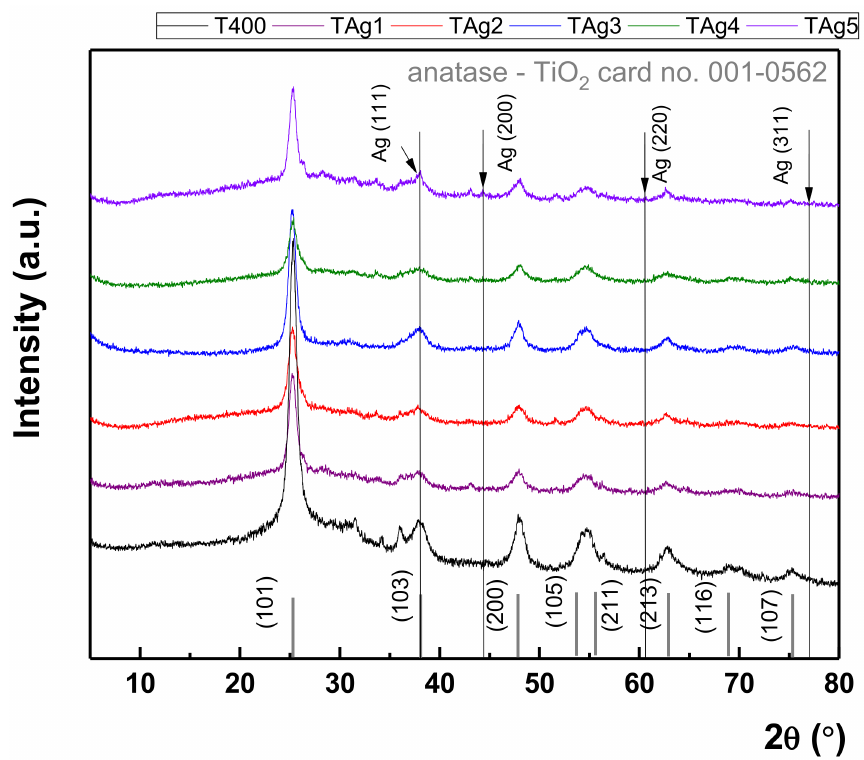
Figure 1. X-ray diffraction patterns of pure TiO 2 and Ag–TiO 2 nanostructured nanofibers materials with different Ag